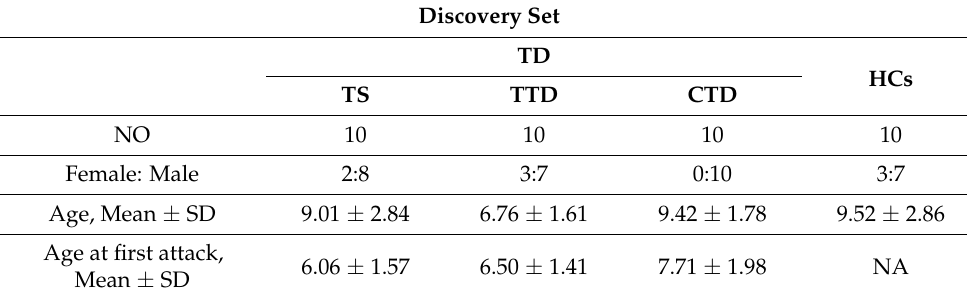
Table 1. Clinical features of all